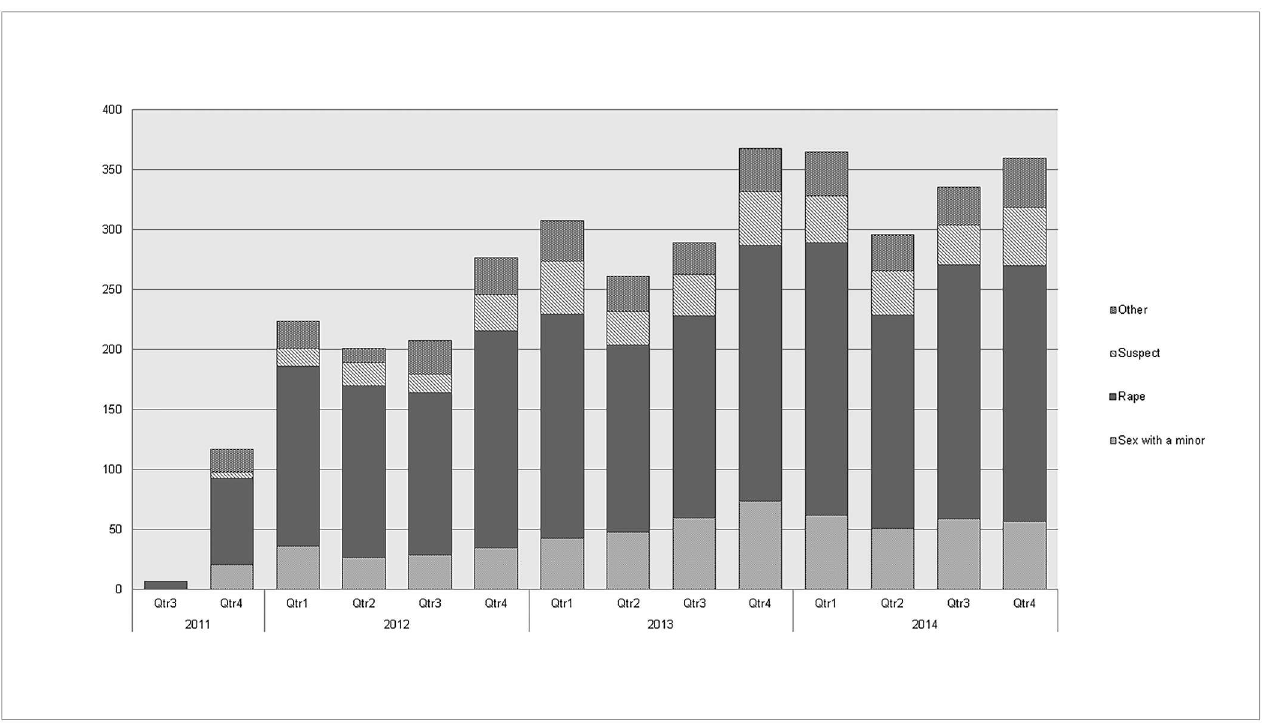
Fig 1. Number new SGBV clients per quarter by reason for visit, Mbare SGBV clinic (09/2011–12/2014).